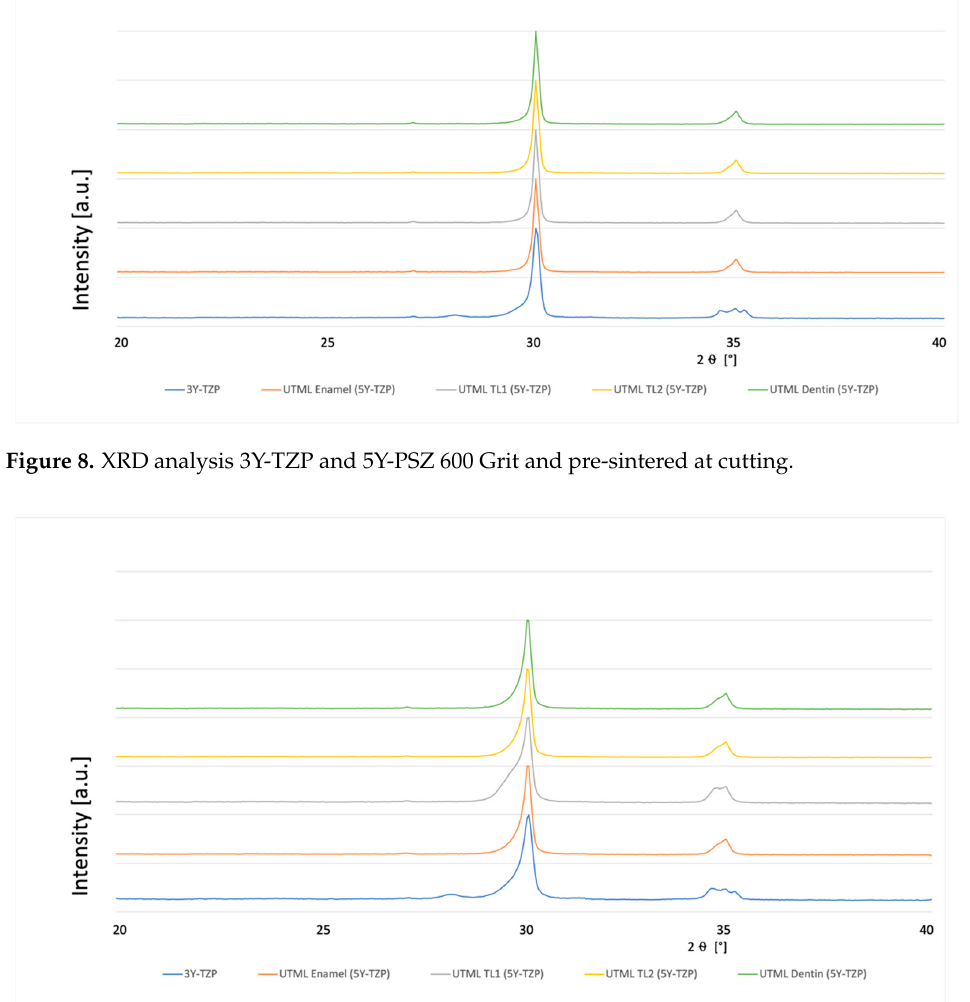
Figure 9. XRD analysis 3Y-TZP and 5Y-PSZ air abraded with alumina particles 50 µm and pre-sintered at cutting. Table 4. Medians, means and standard deviations (SD) in MPa of the biaxial flexural strength of test groups (N = 10) measured with piston-on-three-balls test. Statistically different medians ( p ≤ 0.05) are indicated by different upper-case letters (within a column for analysis of the different materials with the same surface treatment), or by subscript lower-case letters (within a row for the same material with different surface treatment), or by different lower-case Greece letters (comparison of the cutting before and after